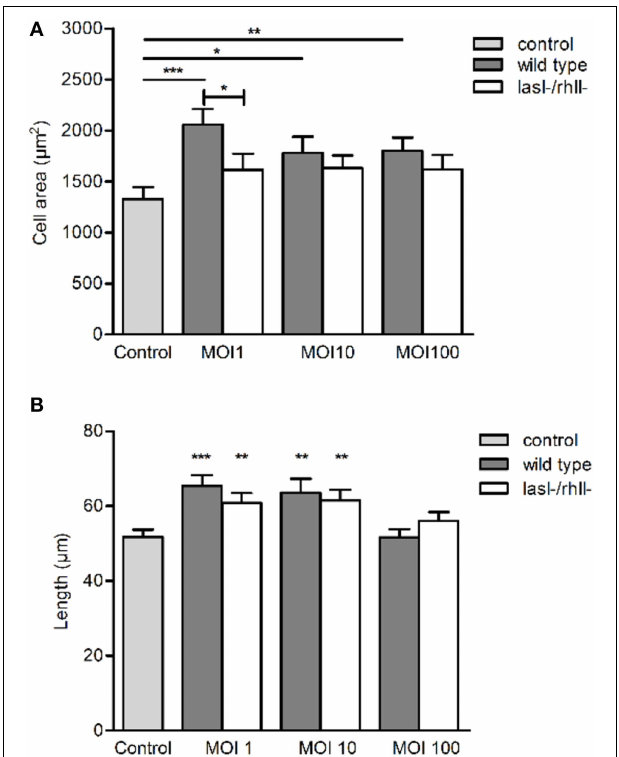
FIGURE 5 | P. aeruginosa affects cell morphology in macrophages. Macrophages were infected with wild type P. aeruginosa, the lasI-/rhlI- mutant or were non-infected (Control), stained, and imaged as in Figure 4A . (A) Quantification of the macrophage cell area. (B) Quantification of approximated macrophage length (as indicated by white arrow in Figure 4A in the direction of polarization). Columns represent means ± SE of three different experiments with three donors. Significant differences are indicated when * P < 0 . 05 , ** P < 0 . 01 and *** P < 0 . 0001 , as analyzed by two-tailed unpaired Student’s t -test.